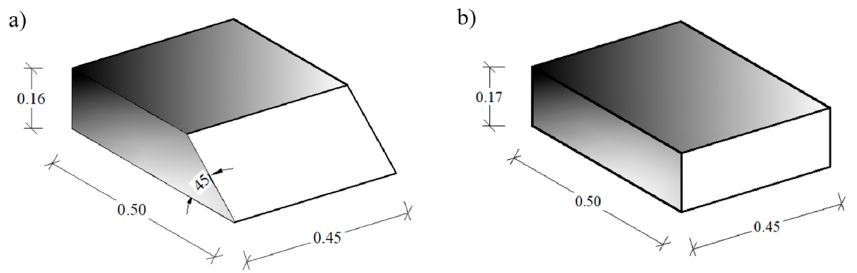
Figure 5. Rigid blocks used to model the landslide (measurement in m): ( a ) trapezoidal solid; ( b ) rectangular